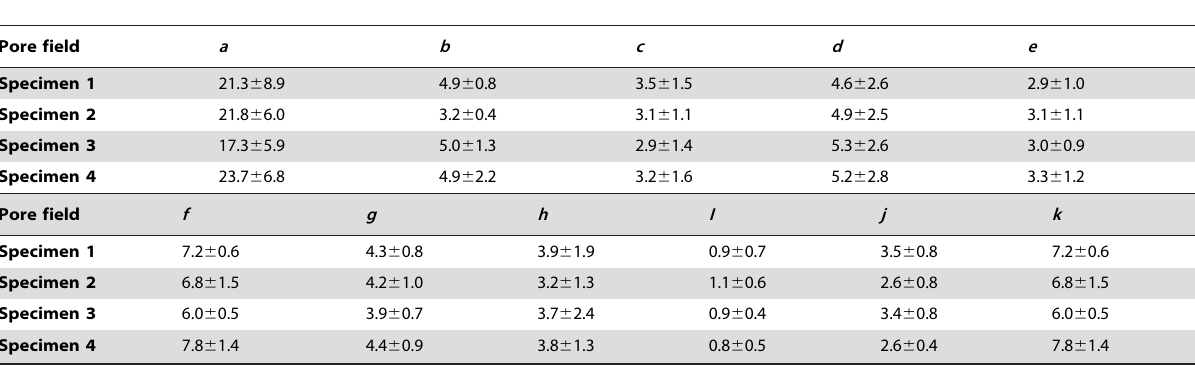
Table 2. Summary of the length of ampullary canals in H. ocellatum